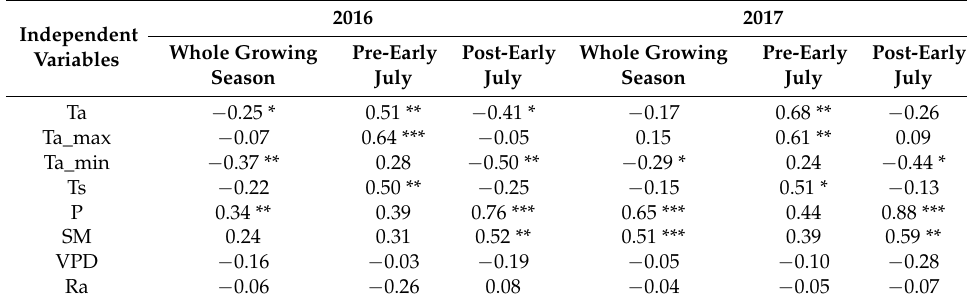
Table 2. Spearman correlation coefficients between stem increments and environmental variables (mean air temperature (Ta, ◦ C), maximum air temperature (Ta_max, ◦ C), minimum air temperature (Ta_min, ◦ C), mean soil temperature (Ts, ◦ C), precipitation (P, mm), soil moisture (SM, m 3 m − 3 ), vapor pressure deficit (VPD, hPa), and solar radiation (Ra, W m − 2 )) during the whole growing season and two separated growing phases in 2016 and 2017. Pre- and post-early July growing phases were separated by DOY 185 (see Figure